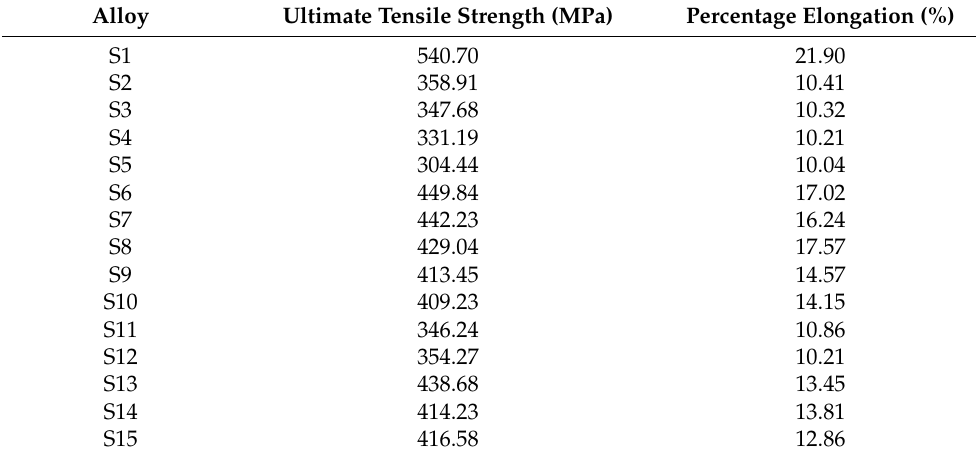
Table 5. Tensile test results of all